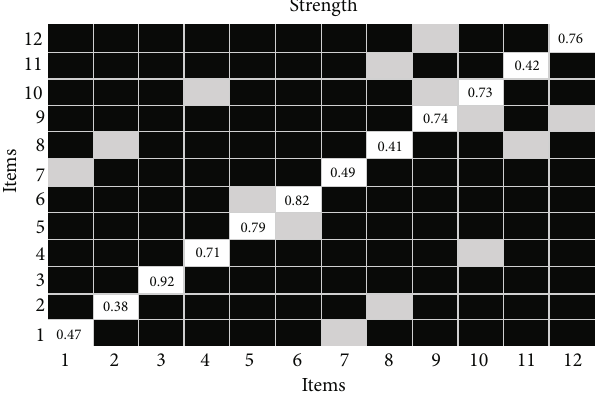
Figure 2: Centrality indexes of chronic conditions. Note: numbers refer to a chronic condition identi fi ed in Table 2. (1) Obesity, (2) cancer, (3) high blood pressure, (4) high blood cholesterol, (5) heart attack, (6) coronary heart disease, (7) stroke, (8) asthma, (9) respiratory diseases, (10) arthritis, (11) kidney disease, and (12) diabetes. This fi gure refers to the Bootstrap di ff erence test for node strength, where gray boxes indicate nonsigni fi cant di ff erences and black boxes indicate signi fi cant di ff erences.